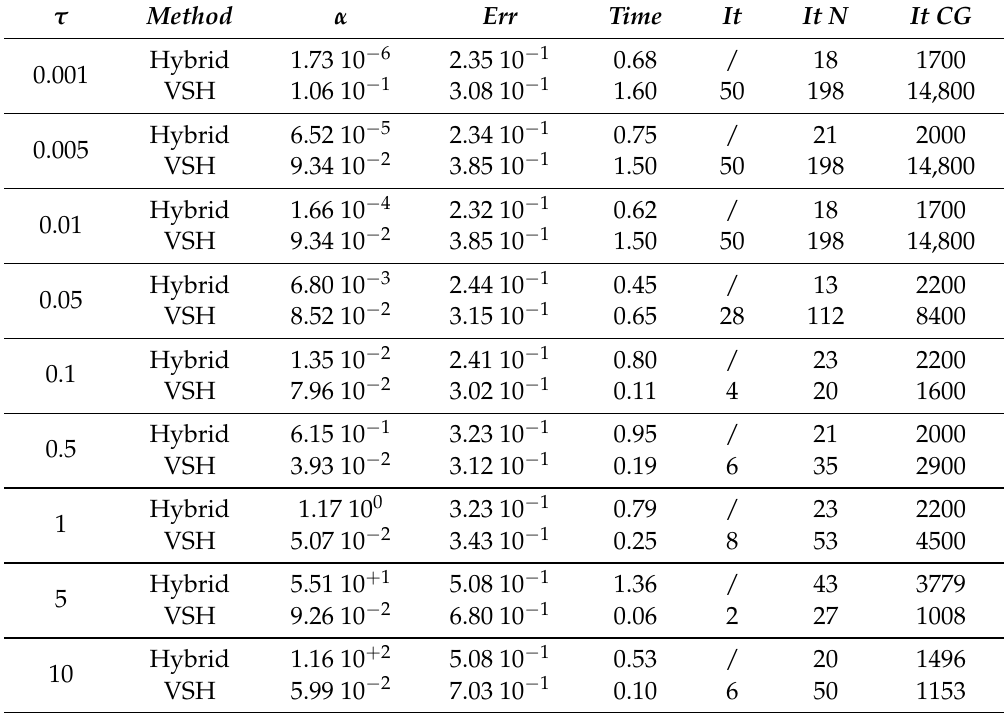
Figure 8. Projections along the T 1 dimension from the Hybrid ( top row ), Tikhonov ( middle row ) and VSH ( bottom row ) models for α = 1 ( left column ), α = 10 − 2 ( middle column ) and α = 10 − 4 ( right column ). The red dashed and blue continuous lines respectively represent the exact projections and the computed ones. Table 2. Numerical results for the methods comparison on simulated NMR